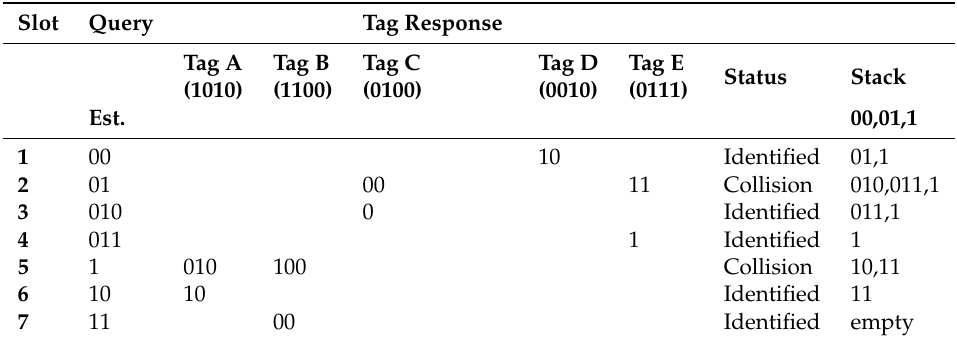
Table 4. Example of the OQTT